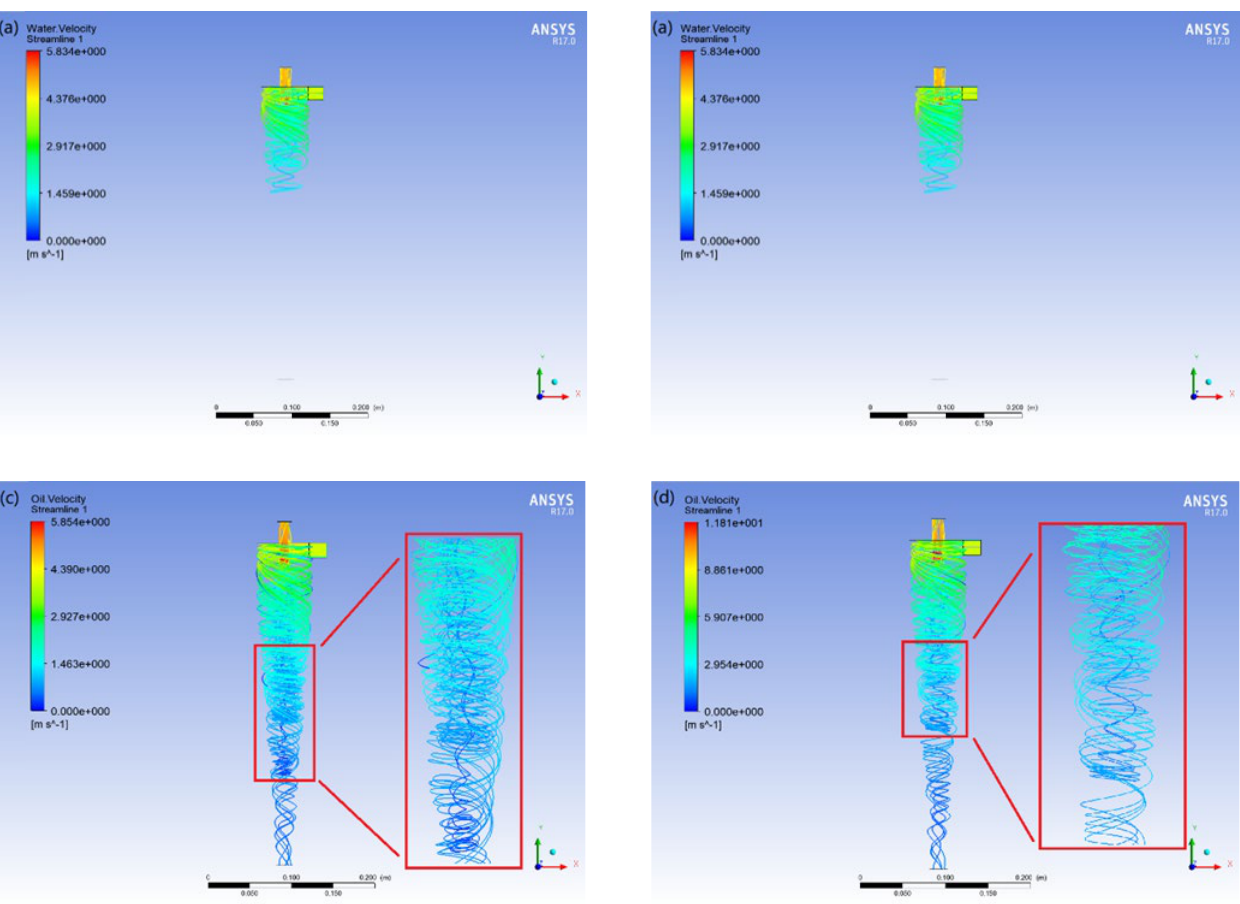
Figure 7. The streamline distribution of water vapor and tar vapor in cyclone. ( a ) Water vapor streamline when inlet velocity is 4.0 m/s, ( b ) water vapor streamline when inlet velocity is 8.0 m/s, ( c ) tar vapor streamline when inlet velocity is 4.0 m/s, and ( d ) tar vapor streamline when inlet velocity is 8.0 m/s.